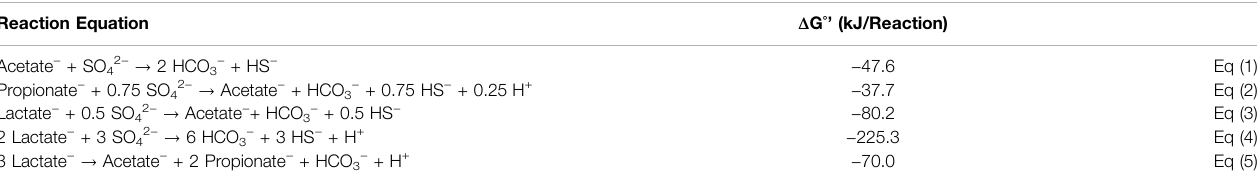
TABLE 1 | Common sulfate-reducing and lactate fermenting reactions, adapted from Thauer et al. (1977). Reaction